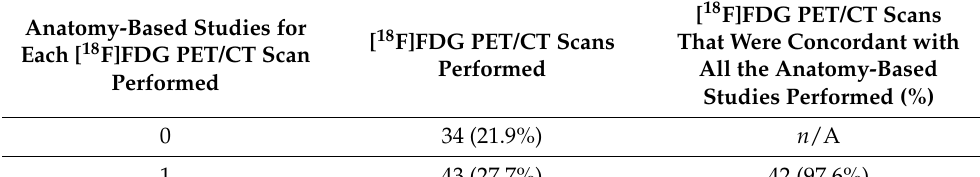
Table 3. Number of anatomy-based studies per [ 18 F]FDG